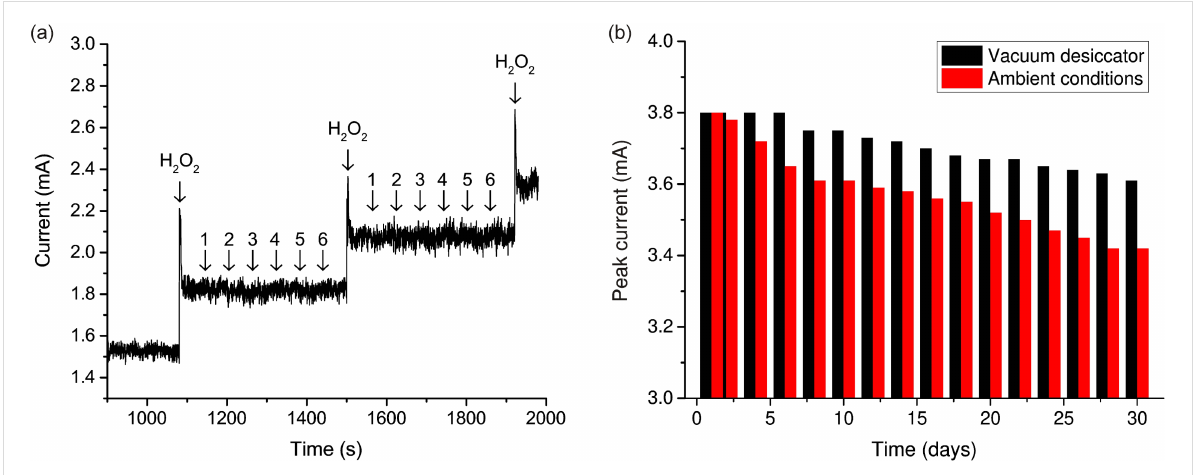
Figure 7: (a) Amperometric response of the nanostructured CuO electrode in 0.1 M NaOH with stepwise addition of H 2 O 2 at concentrations from 100 to 300 μ M and the most common interfering substances: (1) ascorbic acid, (2) uric acid, (3) dopamine, (4) NaCl, (5) glucose, and (6) acetaminophen. (b) Stability study and the dependence of the change in the electrochemical signal on the storage time of the samples.